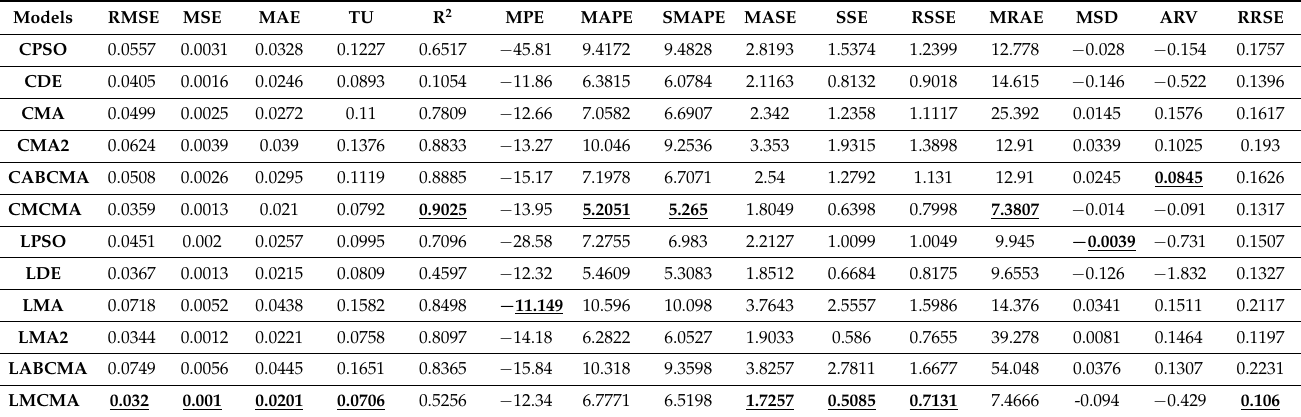
Table 3. Performance Metrics for BTC/USD dataset.